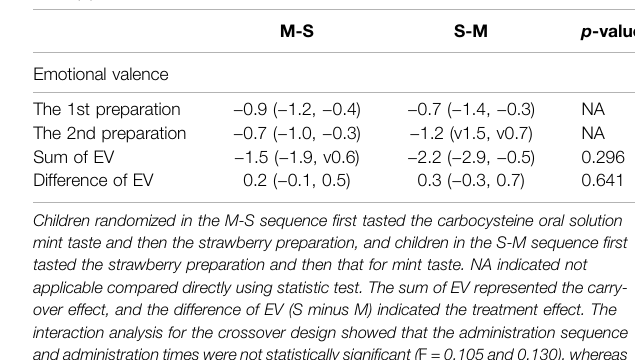
TABLE 1 | The comparisons of emotional valences between two administration sequences of carbocysteine oral solution for mint taste (M) and strawberry taste